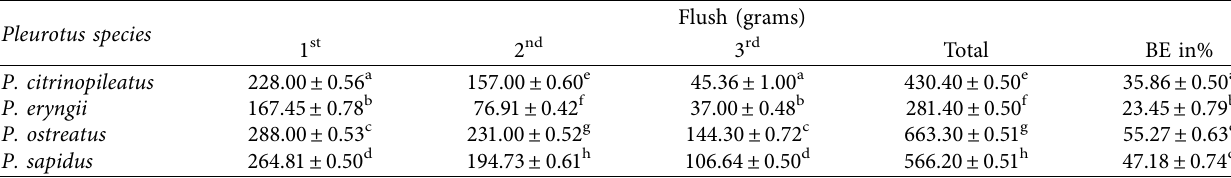
Table 4: Yield and biological efficiency of the four Pleurotus species on composted coffee parchment substrate. Pleurotus species